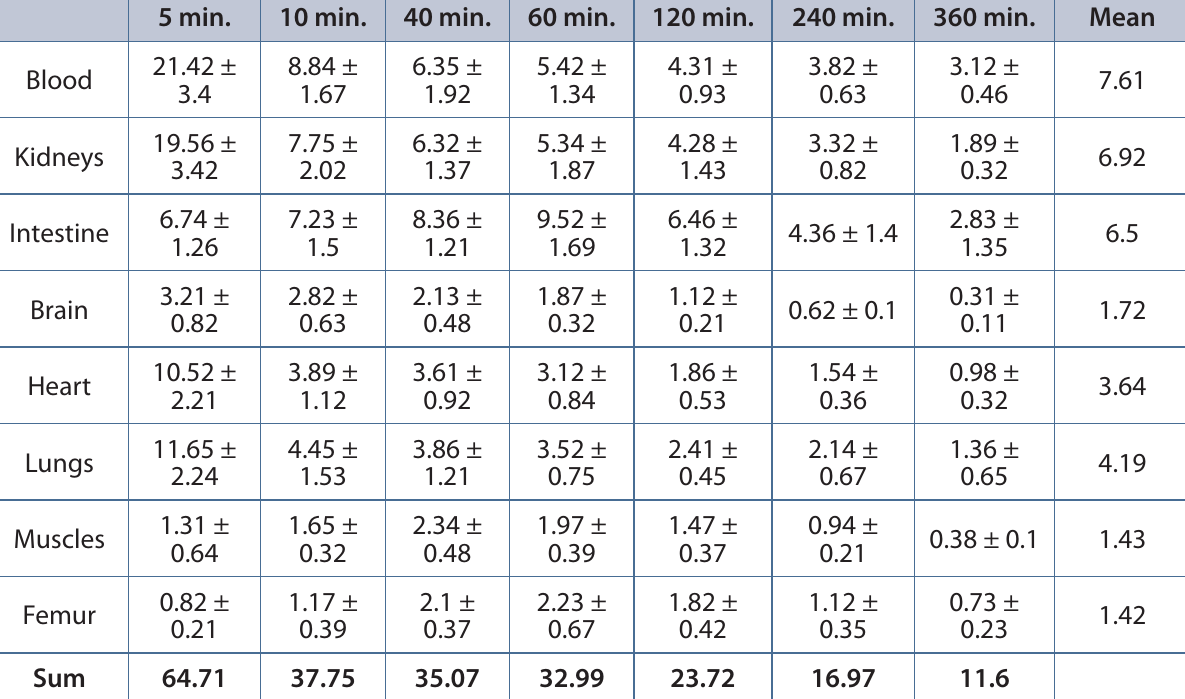
Table 3. Biodistribution of intravenously injected [ 125 I] Razi Institute antivenom in rat expressed as percentage of radioactivity/gram of tissue (mean ± SD; n = 3) upon time (minutes). The times shown represent intervals following administration (0.2 mL 125 I-labeled antivenom per